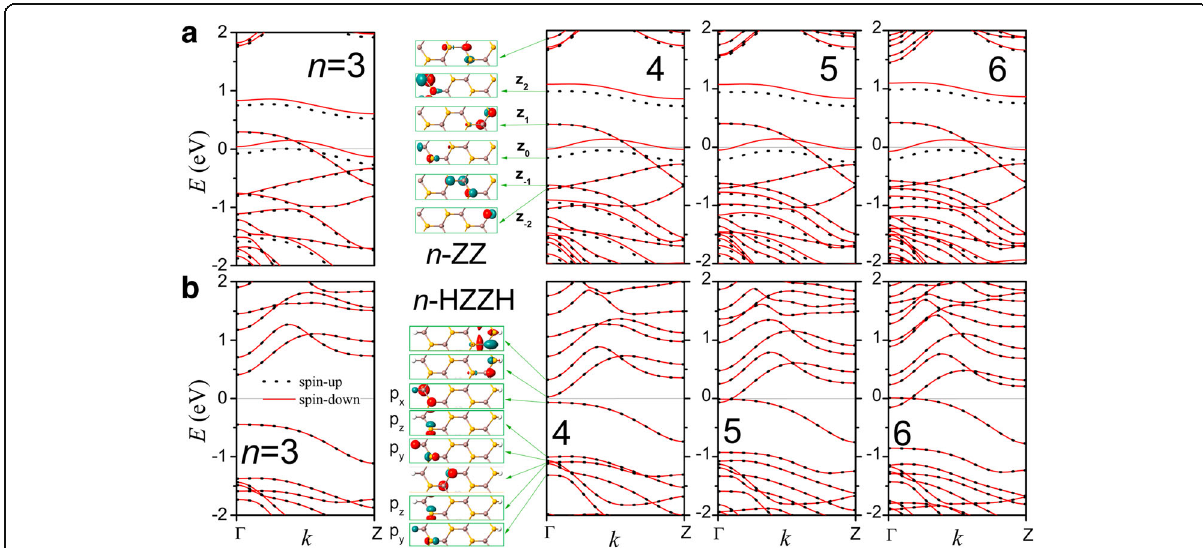
Fig. 2 The band structures of a 3-, 4-, 5-, and 6-ZZ nanoribbons and b 3-, 4-, 5-, and 6-HZZH nanoribbons. Г -point Bloch states near the Fermi en- ergy are shown for n = 4. The orbits of the states below the Fermi energy are indicated for 4-HZZH